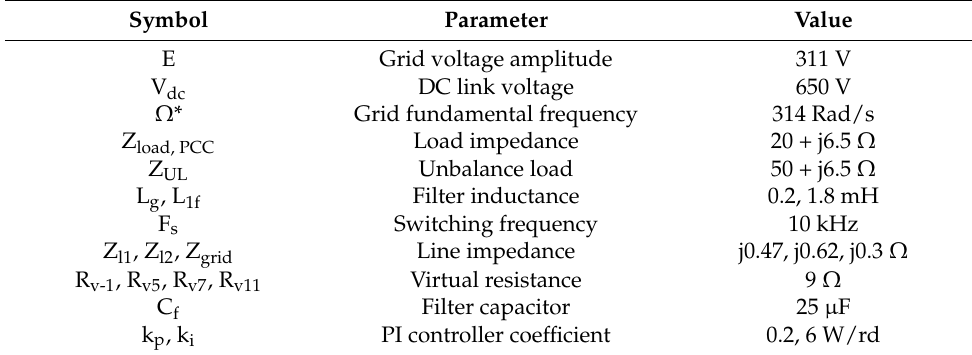
Figure 21. Three-bus microgrid under study. Table 3. Microgrid parameters and control